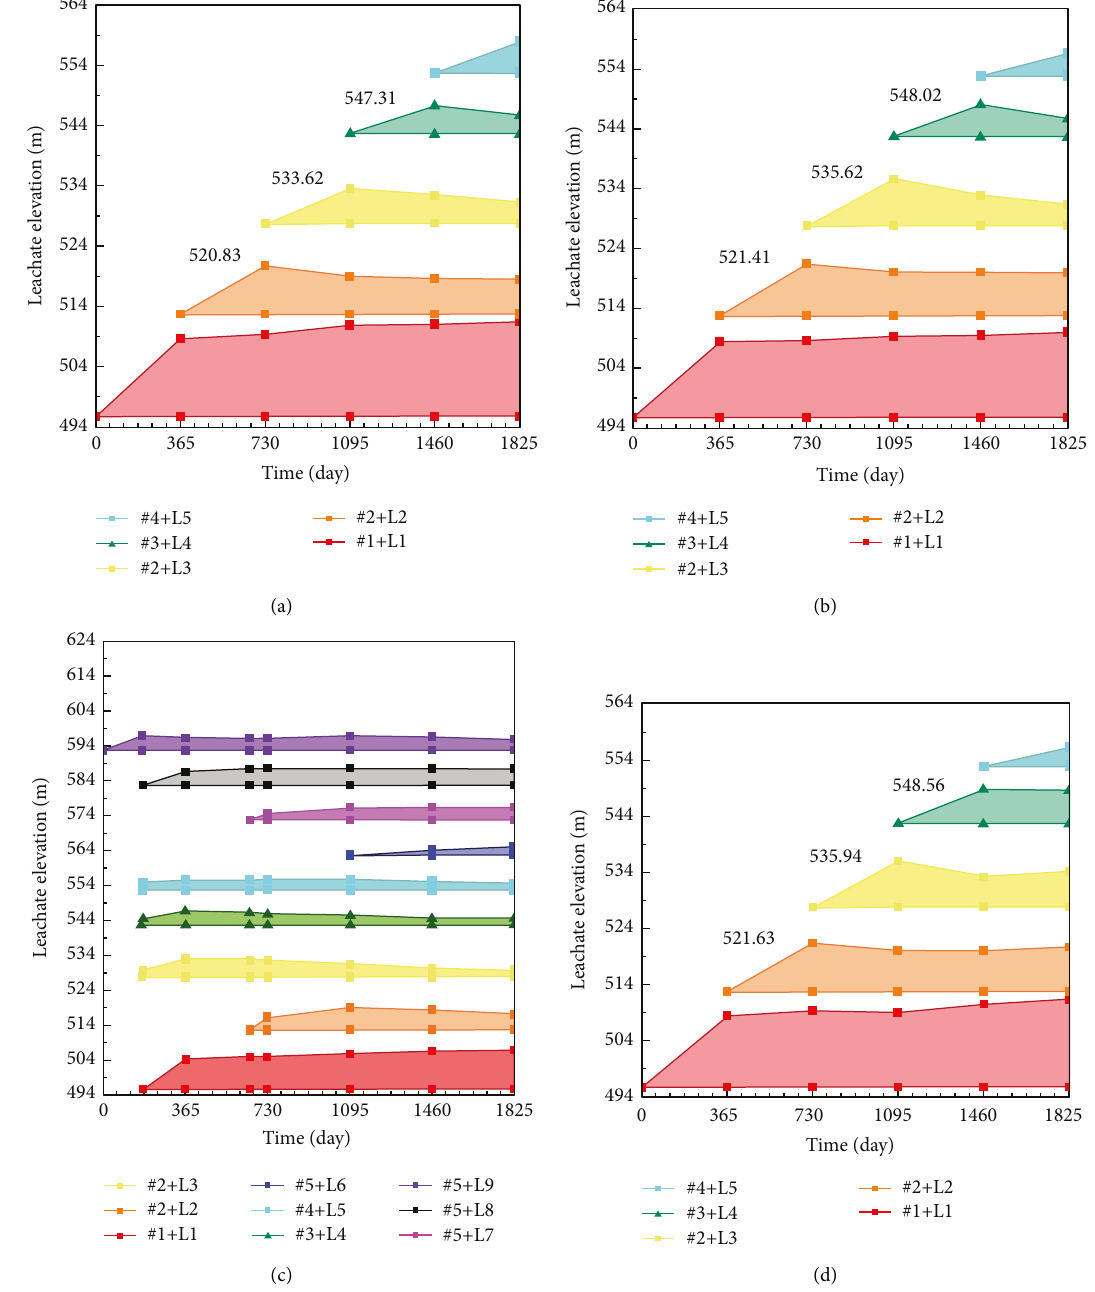
Figure 13: Leachate level distributions of the landfill in the first five years. (a) Scheme 1. (b) Scheme 3. (c) Scheme 5. (d) Scheme 6.